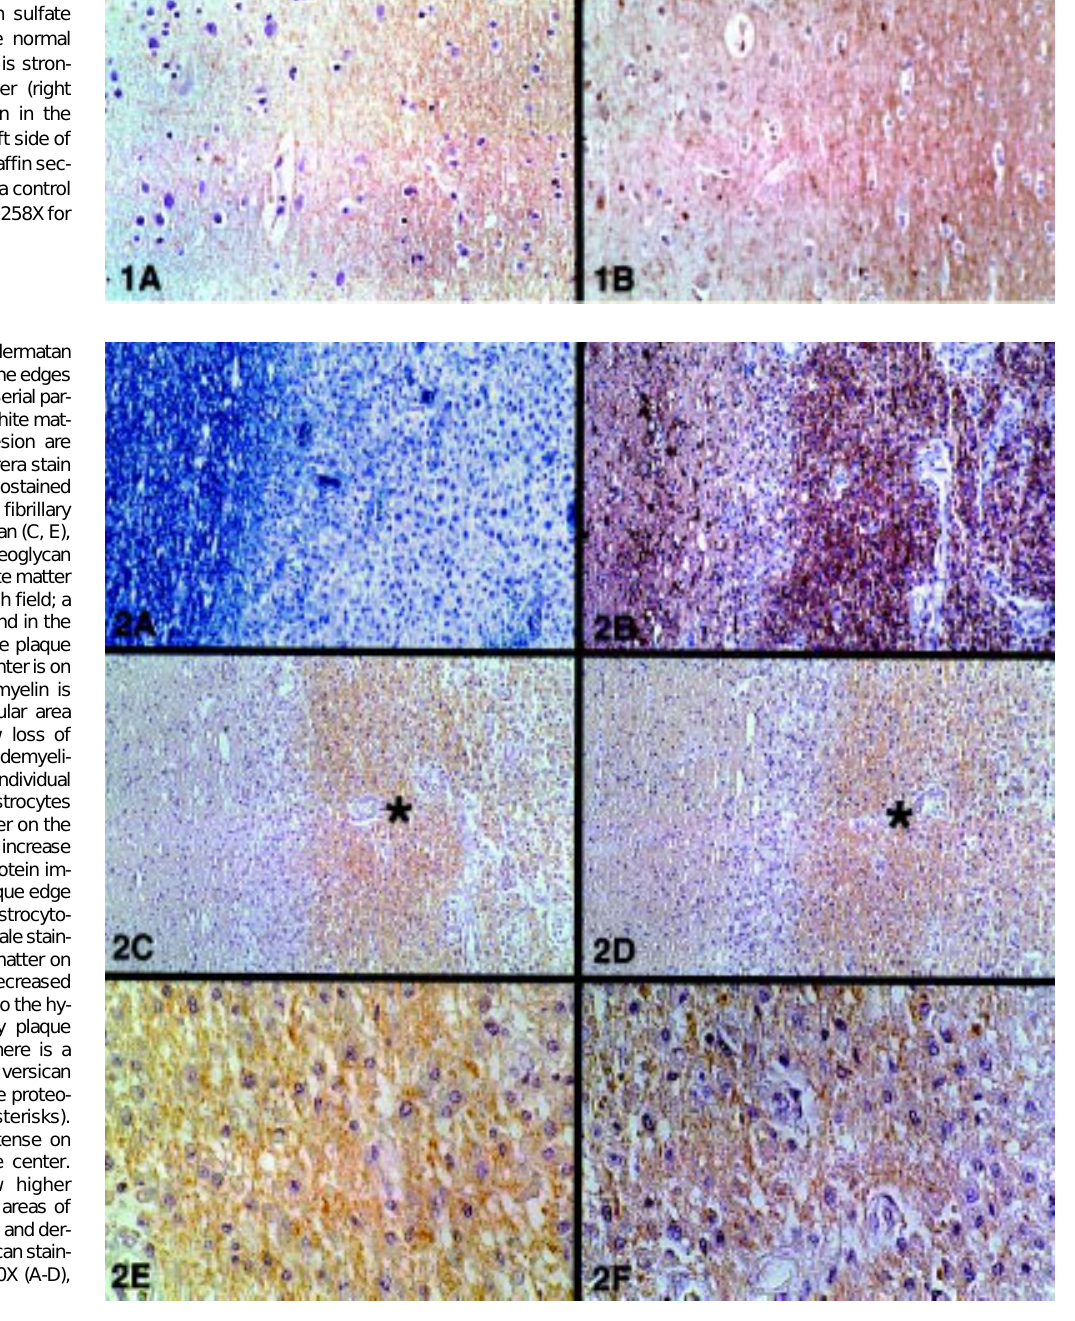
Figure 1. Immunostaining of ver- sican (A) and dermatan sulfate proteoglycan (B) in the normal cerebral ECM. Staining is stron- ger in the white matter (right side of each field) than in the deep cerebral cortex (left side of each field). Both are paraffin sec- tions of cerebrum from a control patient. Magnification = 258X for both.